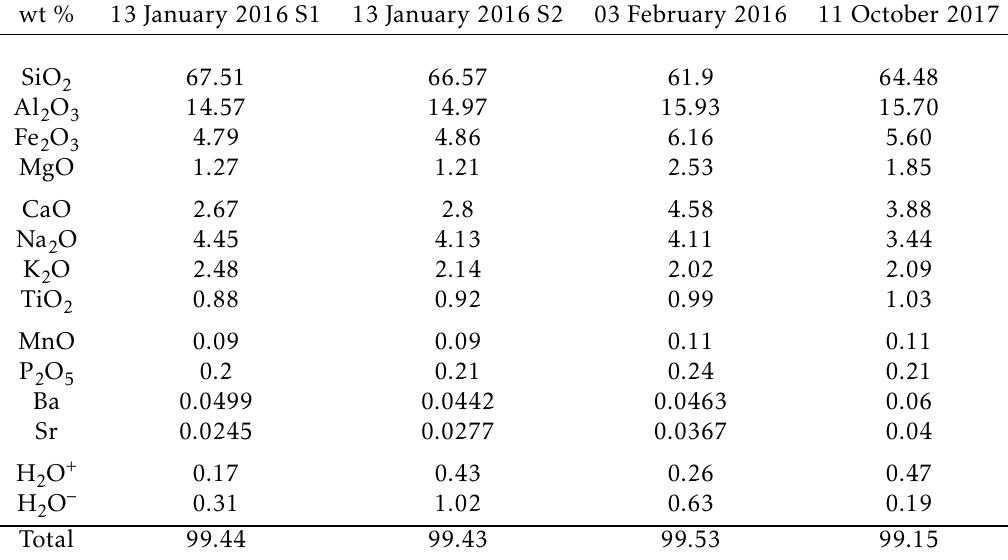
Table 3 – ICP–AES bulk composition of tephra samples. The first two samples were collected on 13 January and originate from ash fall produced by the first eruption on 8 January 2013. The third sample was collected on 3 February 2016, the eruption date producing this ash fall is unknown but constrained between 13 January and 3 February 2016. The fourth originate from an ash fall during an eruption on 11 October 2017. Note the significant di ff erence in composition between the third sample and the